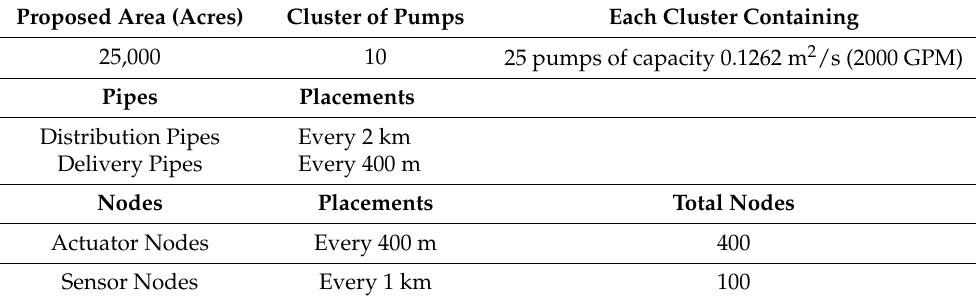
Table 1. Proposed AWD system setup.